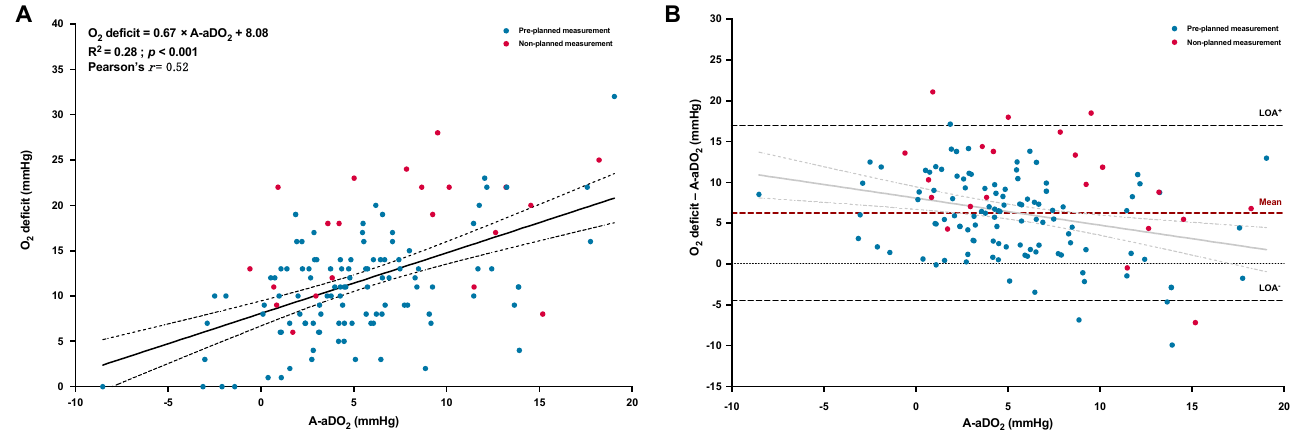
Figure 3. Linear regression and correlation ( A ) between the traditional alveolar-to-arterial oxygen difference (A-aDO 2 ) and the oxygen deficit (O 2 deficit); the solid and dashed lines represent the regression line with the 95% confident interval limits. Bland–Altman plot of agreement ( B ) between the O 2 deficit and the A-aDO 2 , plotted as the absolute difference vs. A-aDO 2 ; the dashed lines represent the mean bias (in red) and the 95% limits of agreement (LOA, in black). Individual values were identified as pre-planned measurement (early morning after a first night at high altitude, blue solid circles) or as non-planned measurement (occurrence of an early altitude-related adverse health effect, red solid circles).